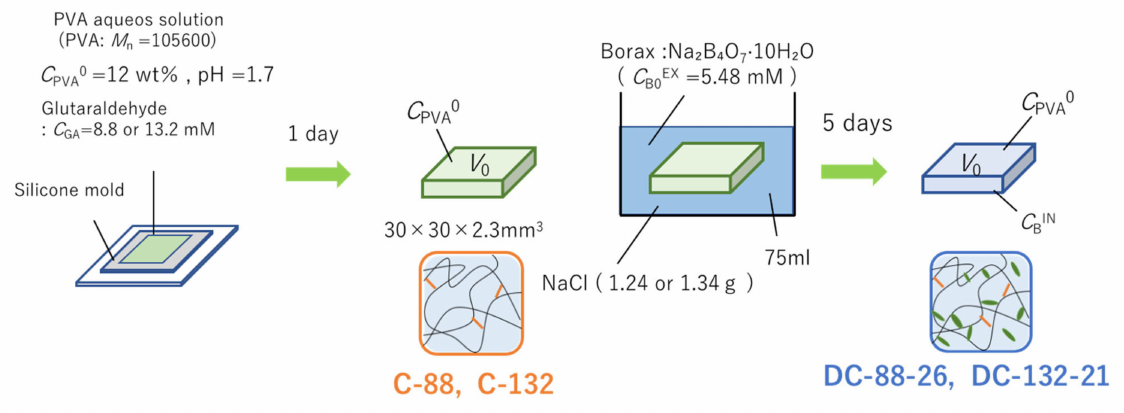
Figure 2. Schematic of the preparation of DC-PVA